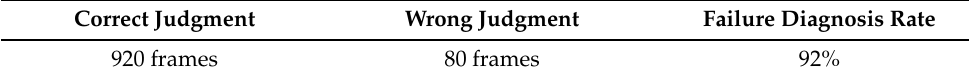
Table 3. Perception effectiveness judgment results (1000